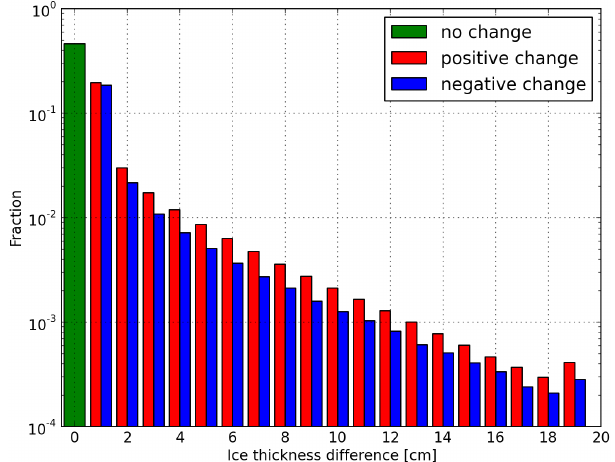
Fig. 11. Histogram of daily change of SIT from 1 October to 26 De- cember